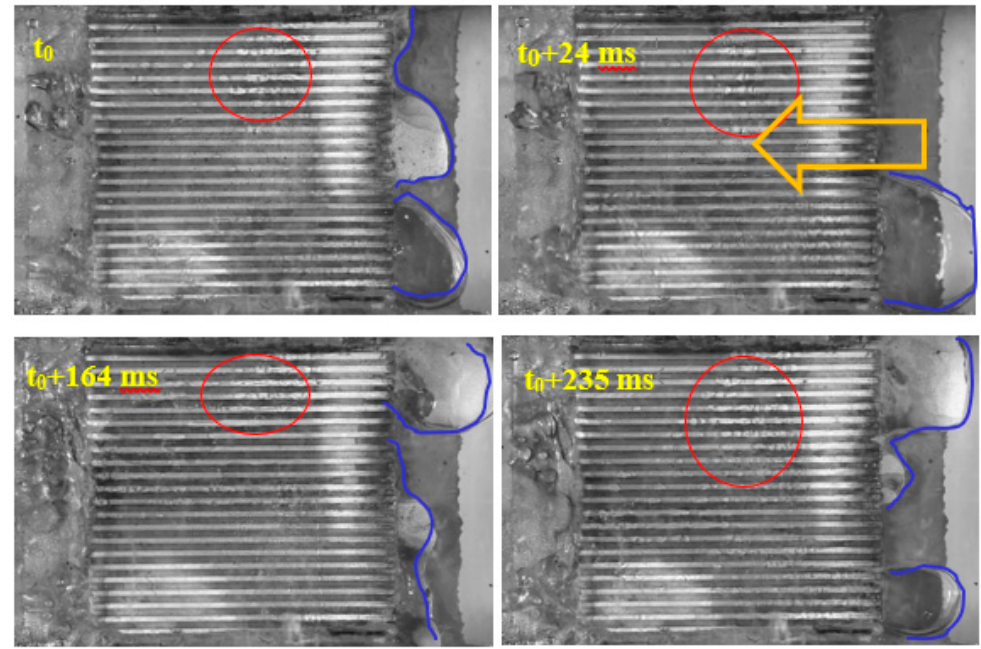
eff = 121.2 W/cm 2 ).